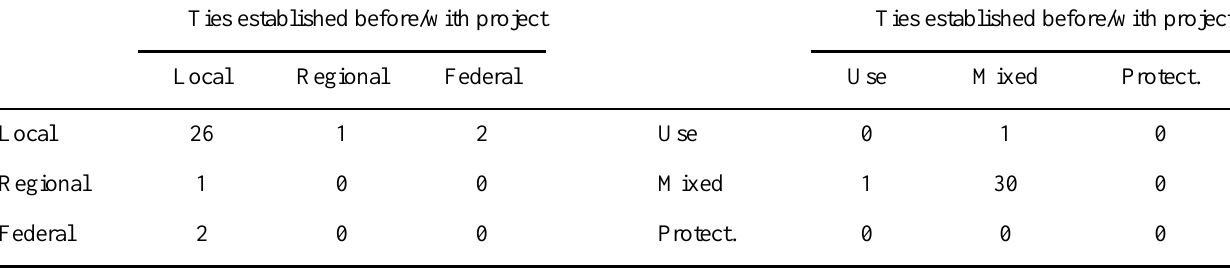
Table 4. Tie strengths between levels and sectors, Thal (close collaboration). Ties established before/with project Ties established before/with project Local Regional Federal Use Mixed Protect.